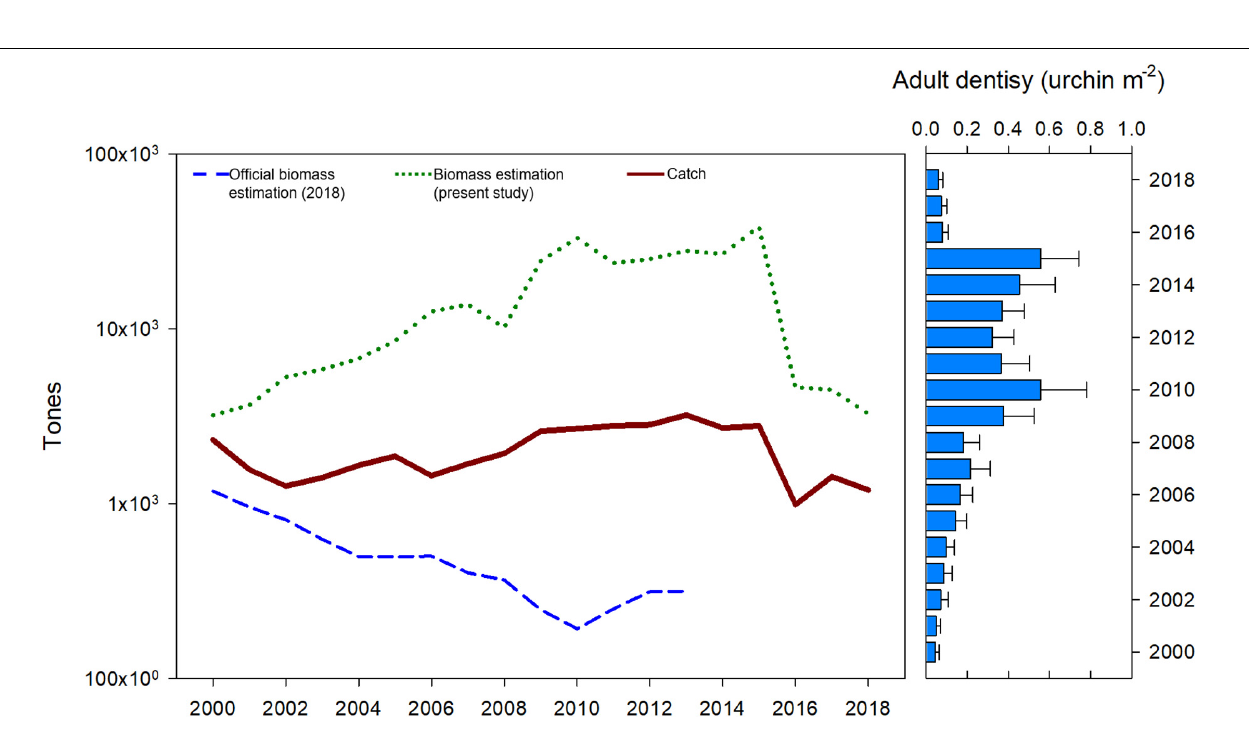
FIGURE 8 | Official red sea urchin estimations (DOF, 2018), total catch, harvestable biomass estimations and adult urchin average density from this study.